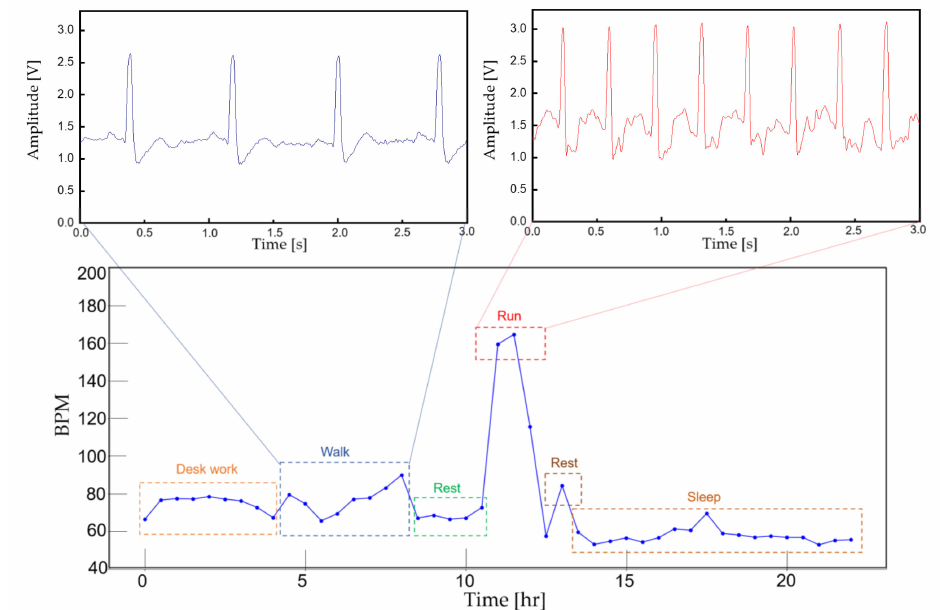
Figure 14. A continuous 30 min averaged BPM for 24 h. The actual ECG signal is displayed for walking and running activity.